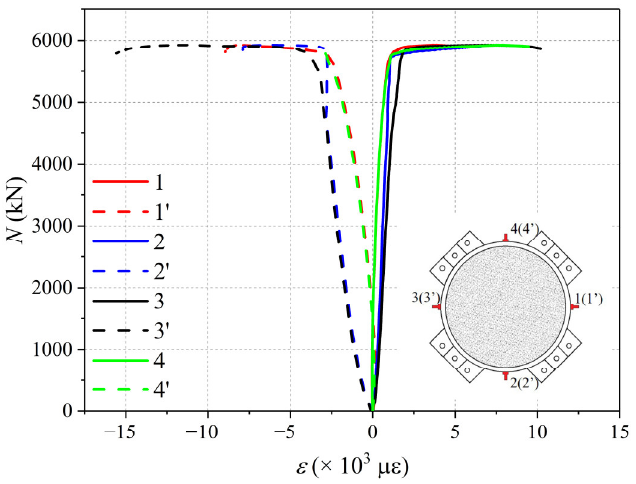
 Figure 11. N- curves at the cross-section of a 1/2 height of BWCFST specimen without initial im- perfection.  Figure 10. N- ε curves along the axial side of BWCFST specimen without initial imperfection. Figure 10. N- curves along the axial side of BWCFST specimen without initial imperfection.